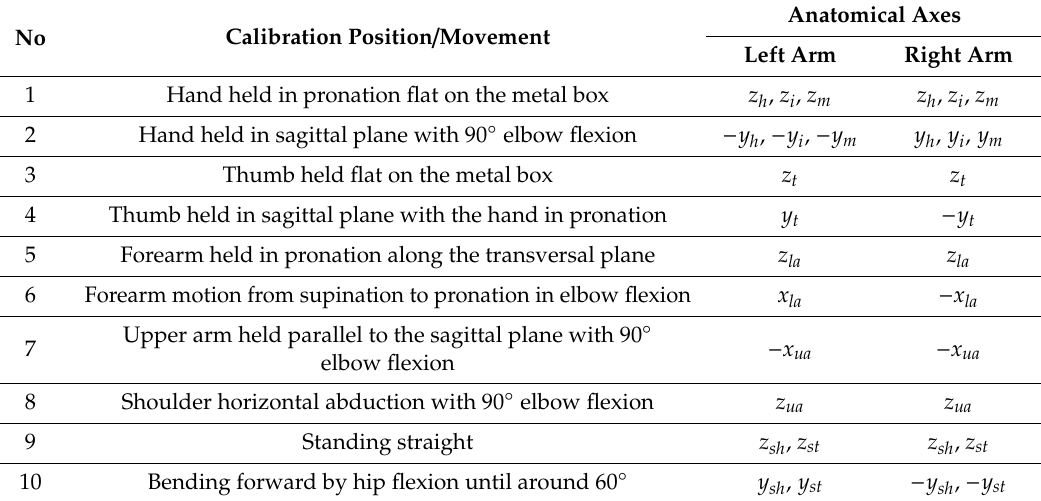
Table 1. Sensor-to-segment calibration